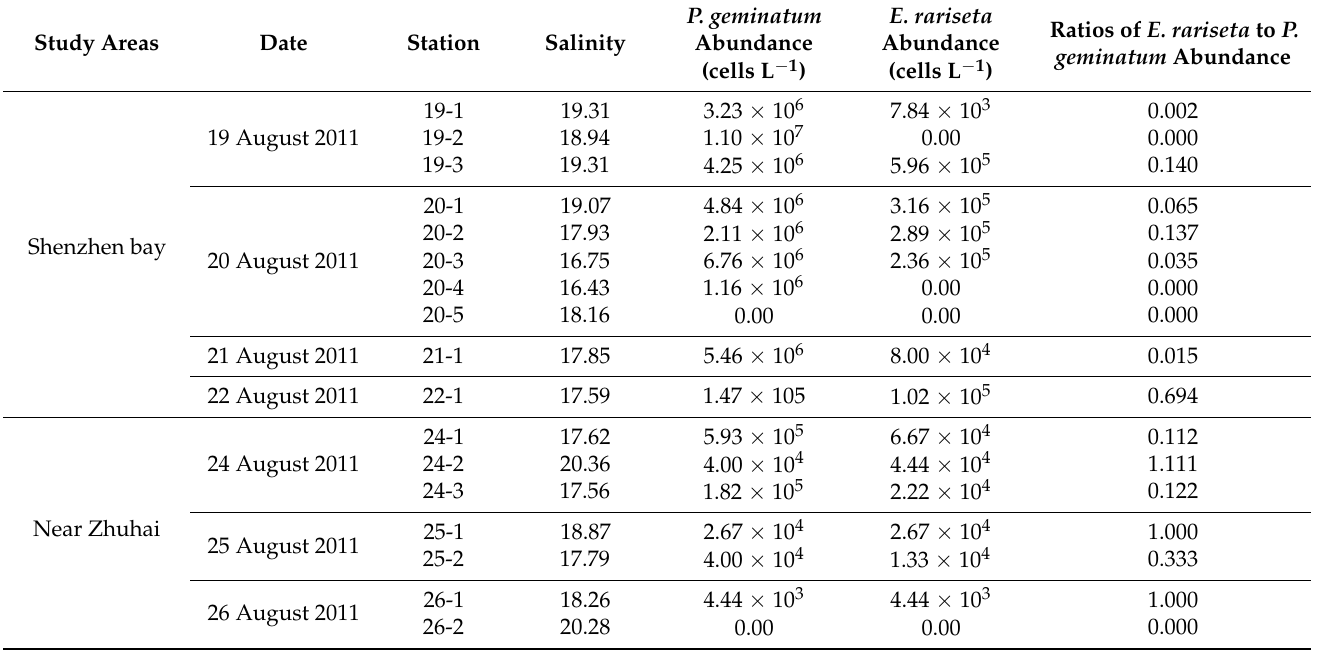
Table 2. Abundance of Polykrikos geminatum and Euplotes rariseta , and ratios of E. rariseta to P. geminatum cells from P. geminatum bloom water in the Pearl River Estuary, August 2011.